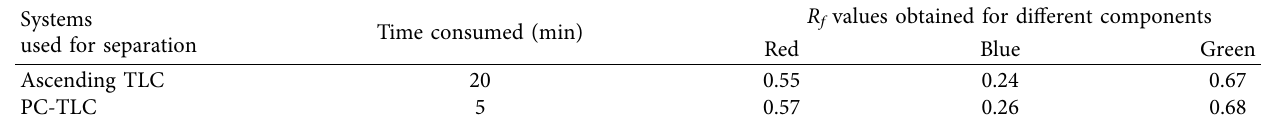
Table 3: Separation of ballpoint ink by classical and pressurized TLC.